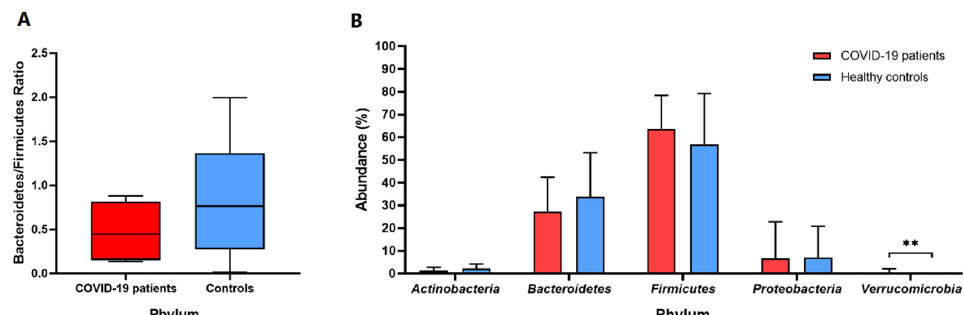
Figure 3. Bacteroidetes/Firmicutes ratio ( A ) and the main phylum-level abundance ( B ) in the gut microbiota among COVID-19 patients and healthy controls (median, quartile Q1–Q3, min–max, and mean values with SD, respectively). ** p < 0.01 calculated using the non-parametric Mann–Whitney test based on medians.